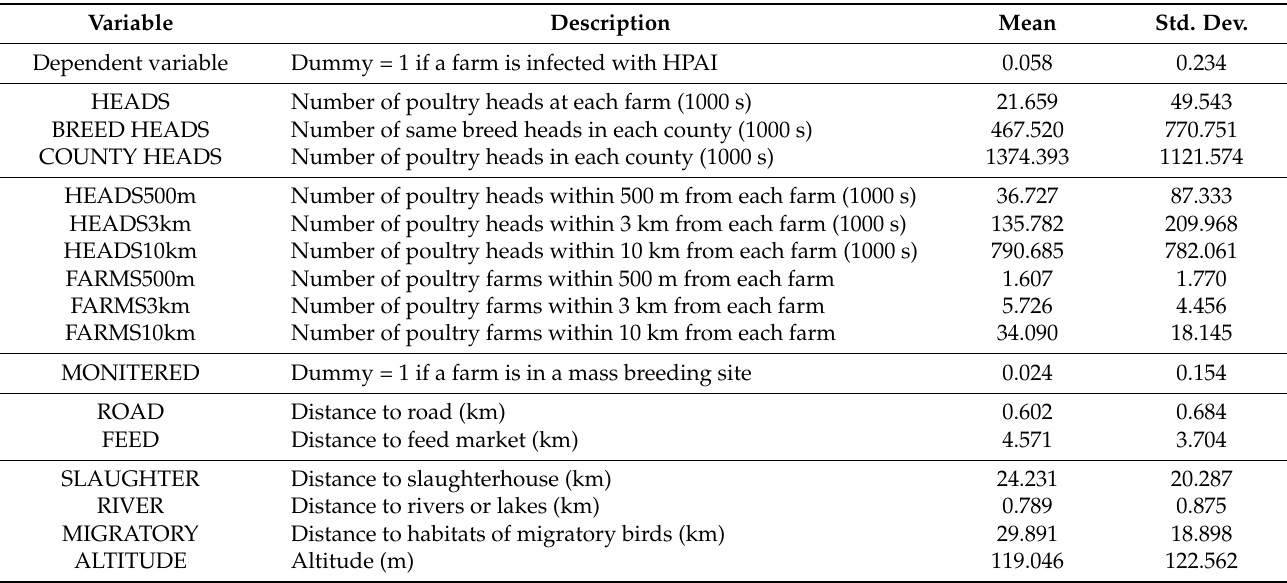
Table 2. Descriptive statistics ( N =